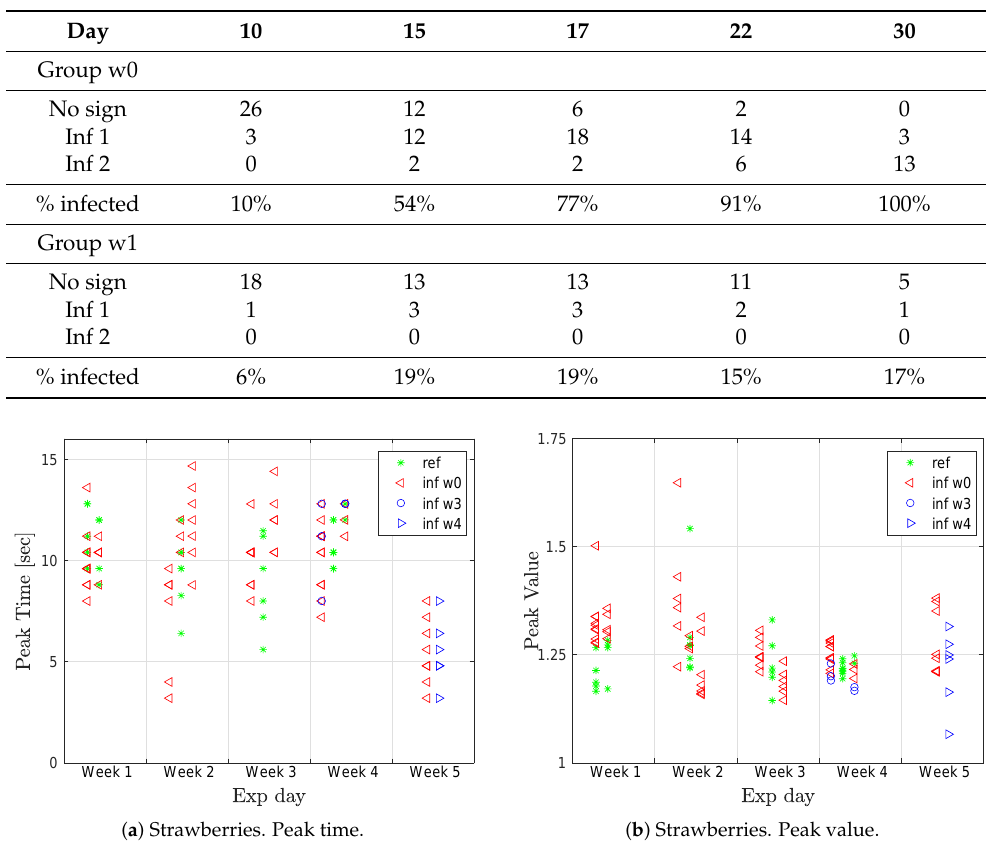
Table 4. Powdery mildew experiment. Numbers of plants that visually showed signs of infection (Inf 1: very light symptoms and Inf 2: slightly more symptoms). The total amount of plants decreases over time as the plants are harvested.